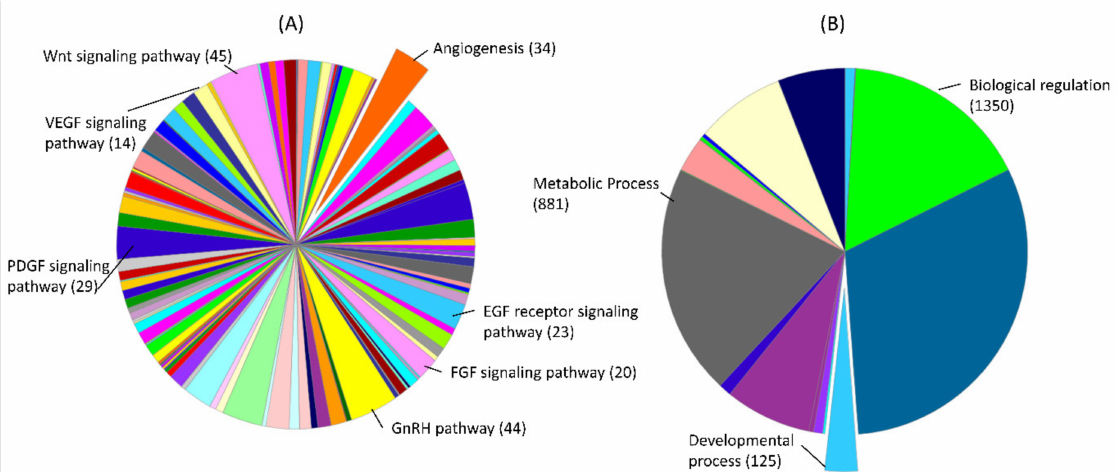
Figure 3. Pathways ( A ) and gene ontologies for biological processes ( B ), derived from Protein Analysis Through Evolution- ary Relationships (PANTHER) classification system (v.16.0), and the number of genes associated with them. The target genes of 17 PE-linked miRNAs from genes List 1 were used in this analysis. A complete list of pathways and biological processes and genes linked with labeled pathways or biological processes is provided in Table